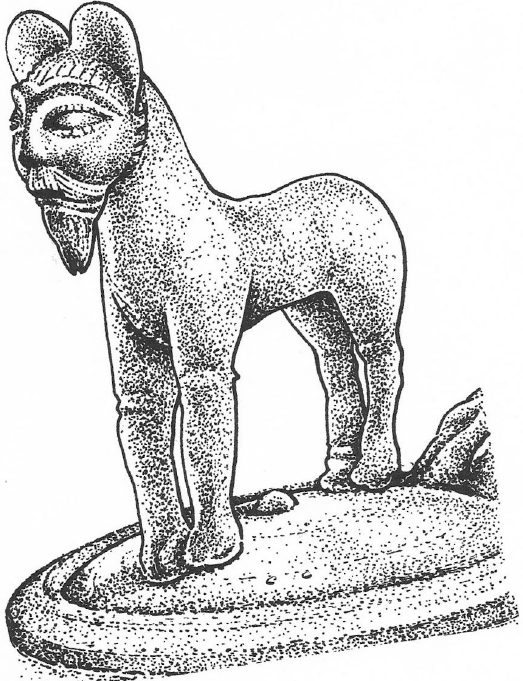
Figure 2. Human-faced horse decorating the lid of a wine flagon from the Reinheim grave. © Anne Leaver.